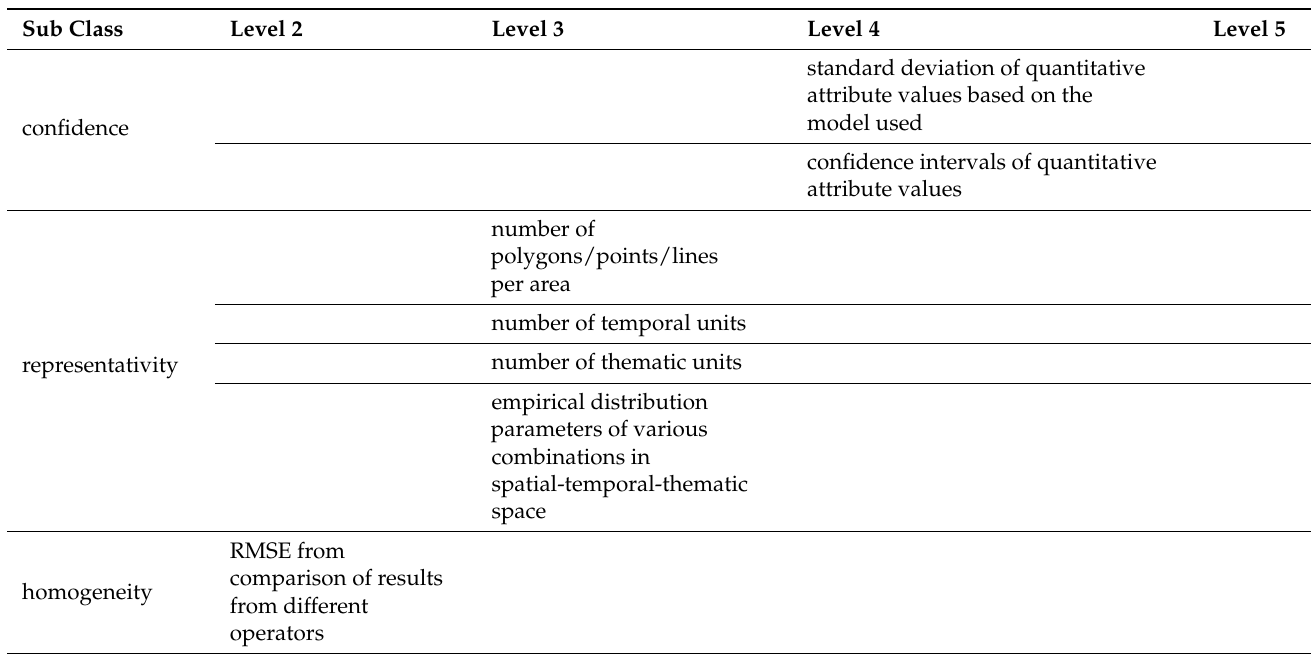
Table A9. Spatial data quality matrix for class